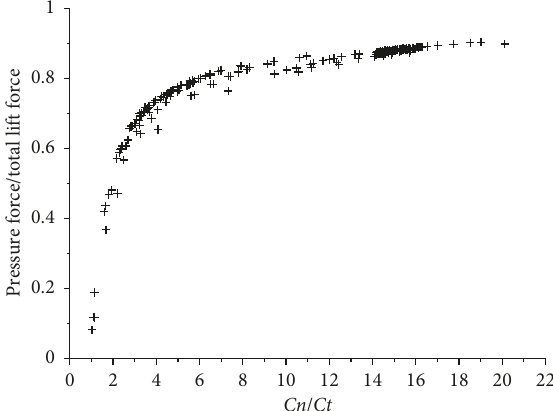
Figure 9: Ratio of pressure on the lift force as a function of Cn / Ct .